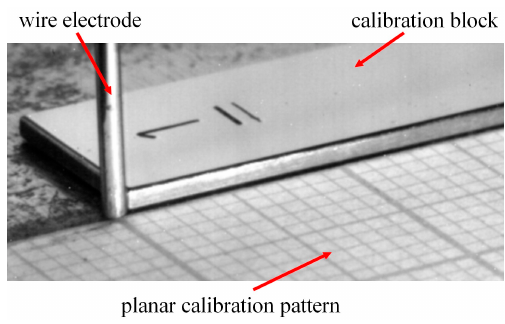
Figure 5. Illustration of planar pattern and calibration block used [22].